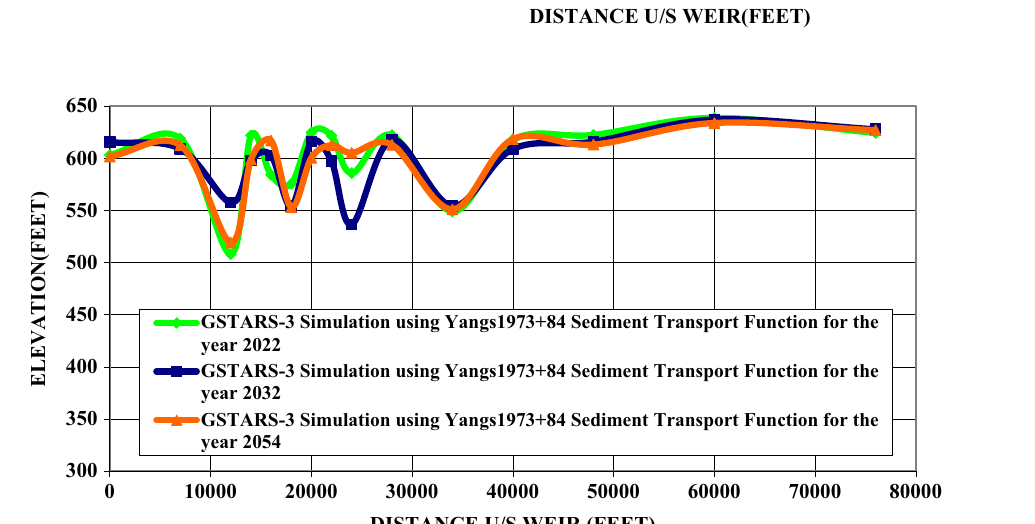
Fig. 6 Simulation results for